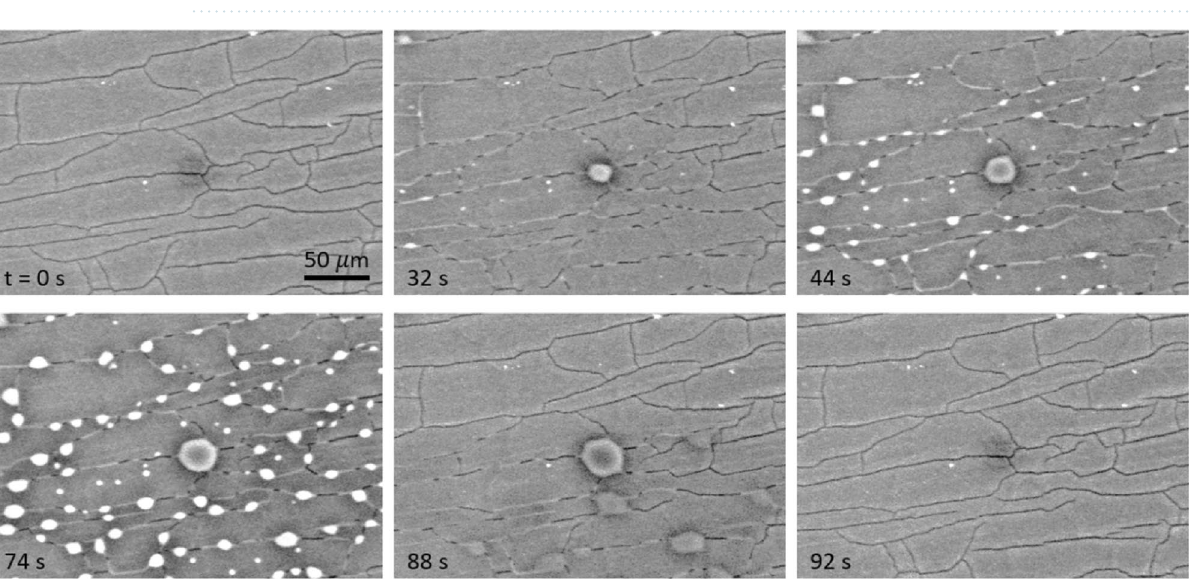
Figure 7. Coating durability. ( a ) The silane coating on the copper tube degraded after 5–8 experimental runs. The heat transfer coefficient for DWC decreased from ≈ 79 kW/m 2 K (first experiment) to ≈ 13 kW/m 2 K (eighth experiment). The enhanced heat transfer coefficient for the inverse opal coated copper tube ( b ) and the oil-impregnated copper tube ( c ) remained nearly the same at ≈ 80 kW/m 2 K (IOC) and ≈ 102 kW/m 2 K (SLIPS) when condensation experiments were conducted for the first, tenth, and twentieth times. This result shows the durability of our coating.